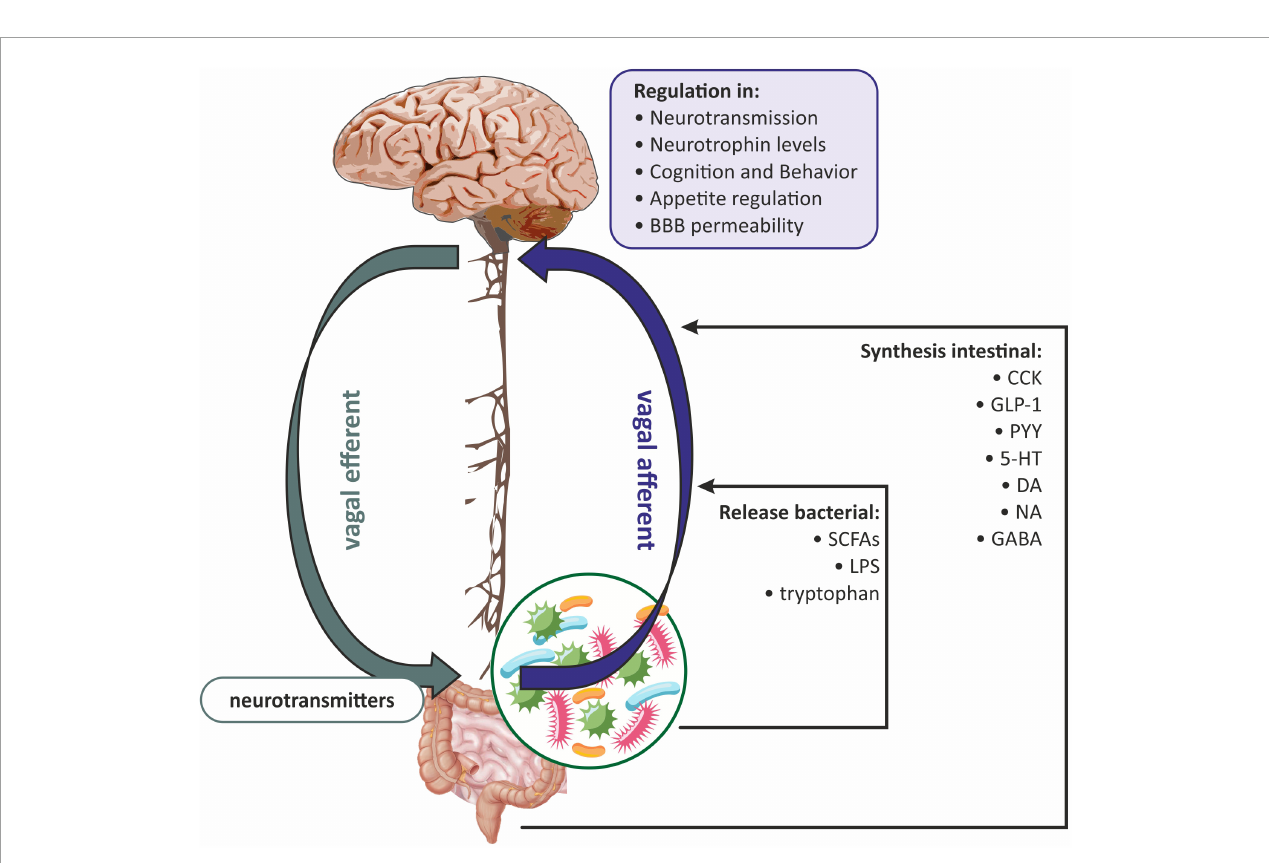
FIGURE3 The role of the vagus nerve in gut microbiota-brain communications. BBB, blood-brain barrier; CCK, cholecystokinin; DA, dopamine; GABA, gamma-aminobutyric acid; GLP-1, glucagon-like peptide-1; 5-HT, serotonin; LPS, lipopolysaccharide; NA, noradrenaline; PYY, peptide YY (PYY); SCFAs, short-chain fatty